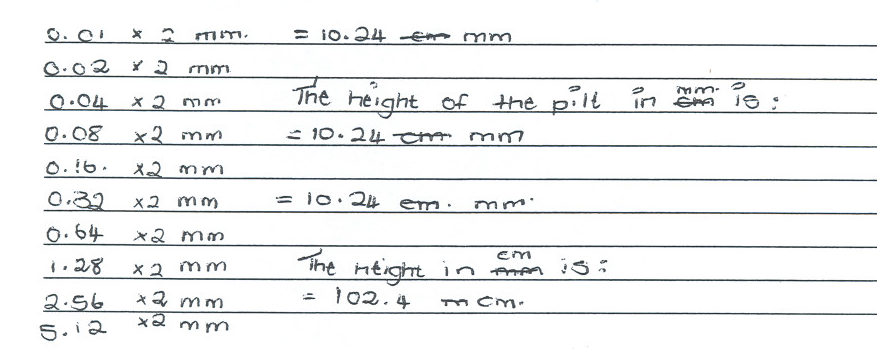
Figure 1: Group 2’s calculation of problem